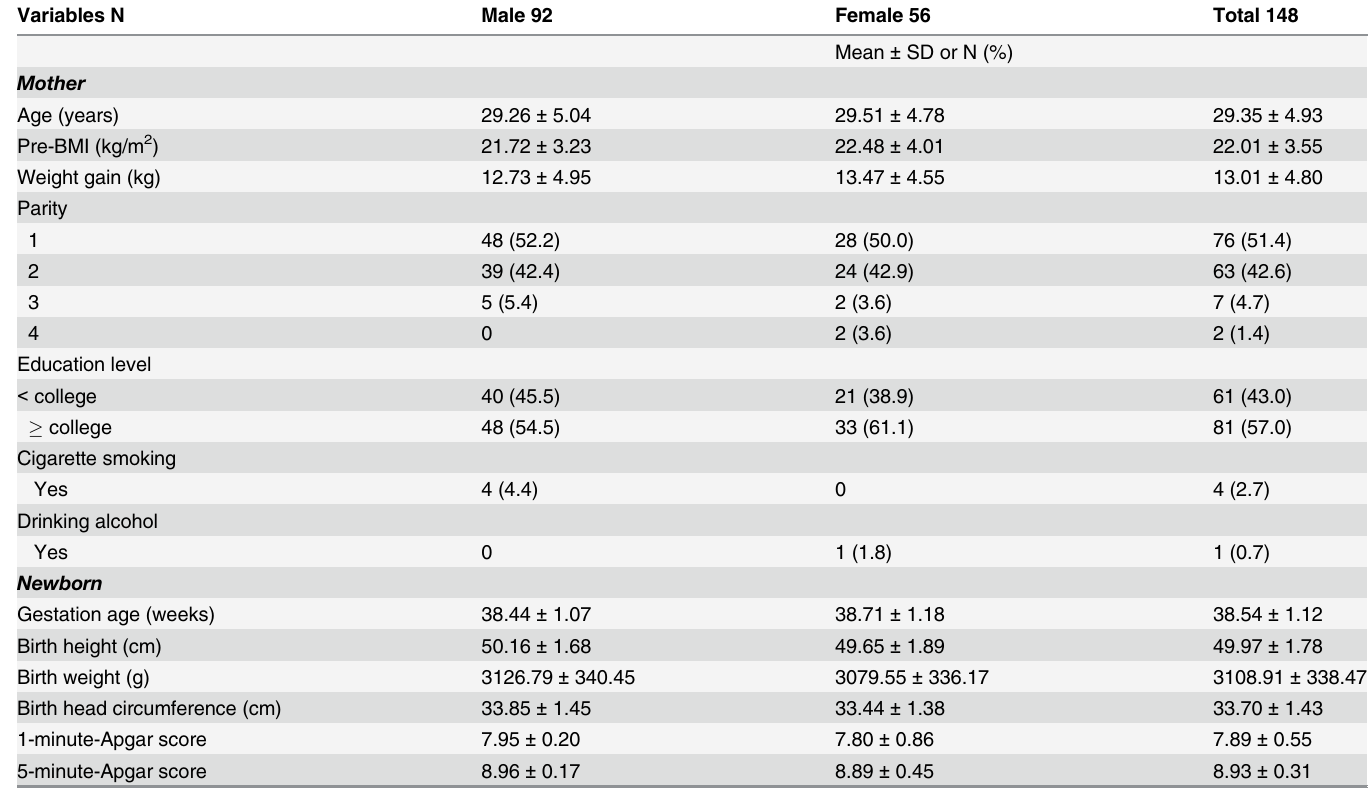
Table 1. Demographic characteristics of participant mothers and their